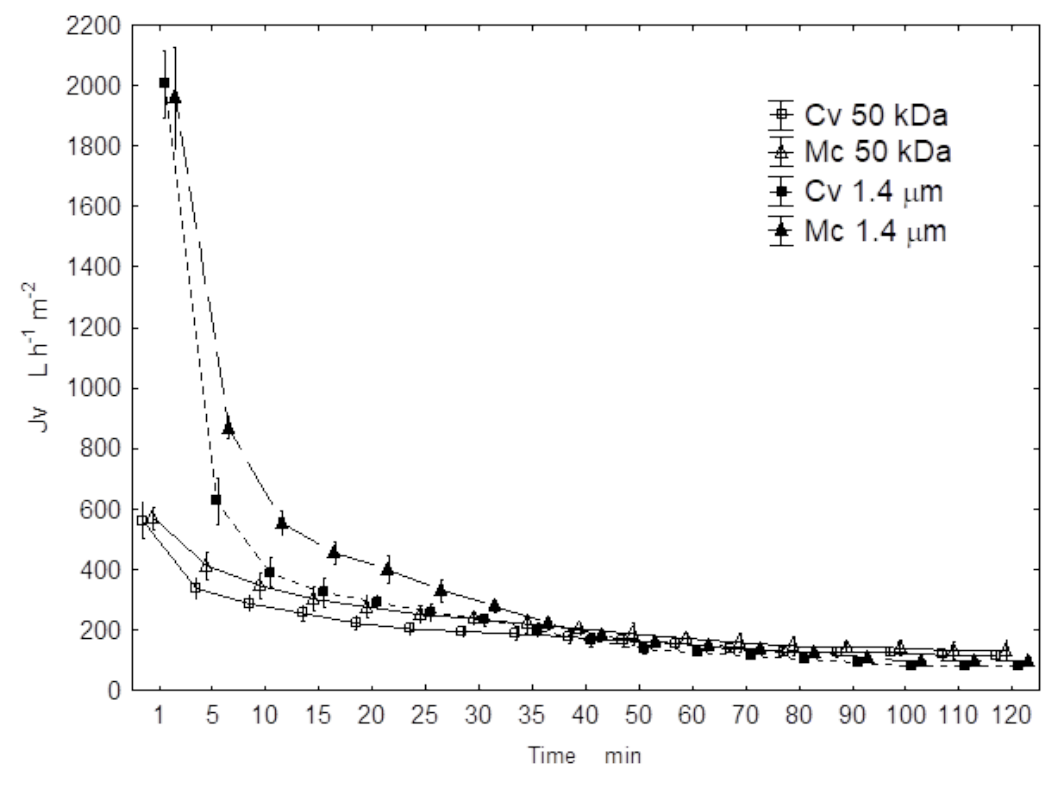
Figure 2. Permeate flux variation (Jv) during 120 min filtration as a function of algal species (Cv– C. vulgaris ; Mc– M. contortum ) and membrane cut-off (50 kDa and 1.4 µm).